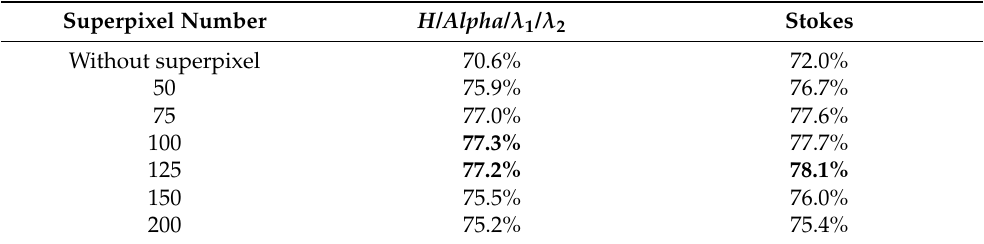
Table 6. MIoU of classification results based on polarimetric parameters with different SLIC super- pixel numbers.